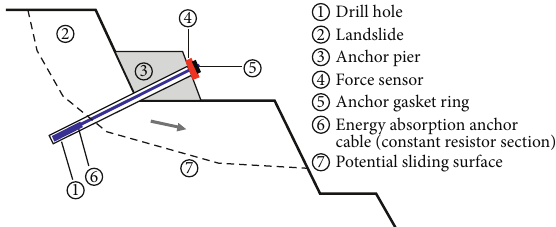
Figure 9: Conventional installation method of the NPR